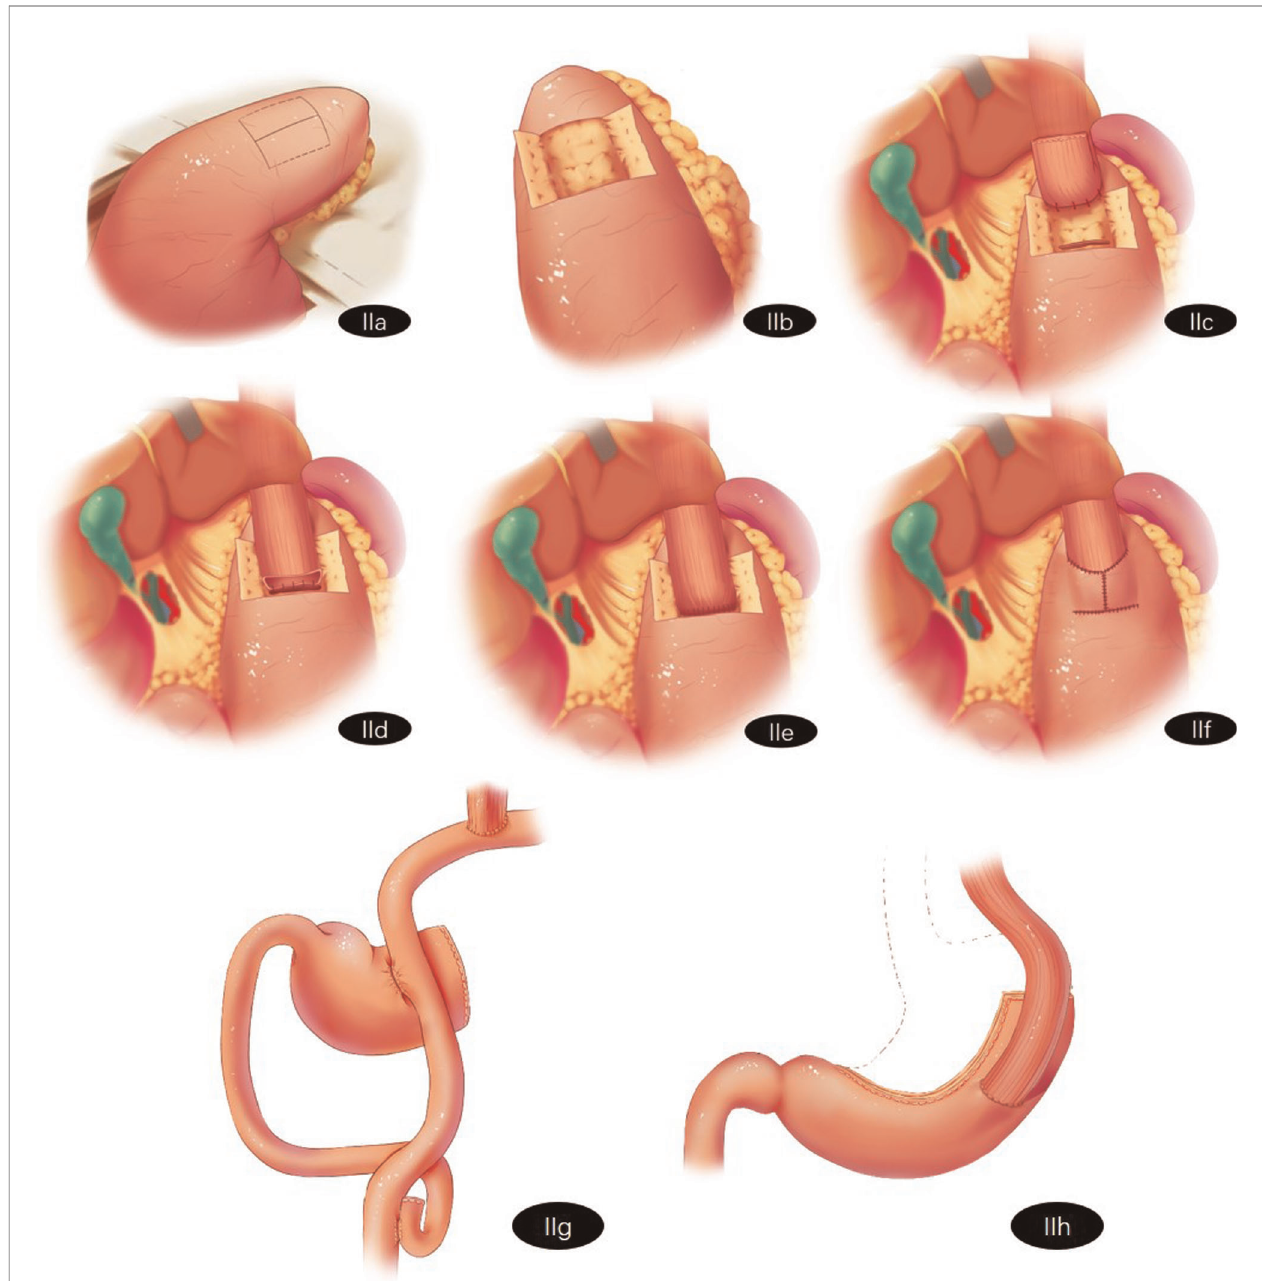
FIGURE 2 | Schematic representation of reconstruction surgery of the digestive tract after proximal gastrectomy ( A ) Kamikawa: A “ H"-shaped seromuscular fl ap (3.0 cm×3.5 cm) will be marked on the anterior wall of the remnant stomach near the greater curvature of the stomach. ( B ) Kamikawa: The sarcoplasmic fl ap will be dissected between the submucosa and musculature. ( C ) Kamikawa: The gastric mucosa “ window ” with similar width to the esophagus will be made at the lower edge of the sarcoplasmic fl ap for anastomosis. Traction will be performed on the esophagus. Three to four stitches will be used to fi x the posterior wall of the esophagus which is 5 cm away from the esophageal stump and the gastric stump at the upper edge of the sarcoplasmic fl ap. ( D ) Kamikawa: The whole esophagus will be sutured continuously with the gastric mucosa and submucosa. ( E ) Kamikawa: The whole anterior wall of the esophagus and the whole stomach will be sutured intermittently. ( F ) Kamikawa: Both sides of the sarcoplasmic fl ap will be sutured intermittently in the shape of a “ Y ” and fi xed with the esophagus to cover the anastomosis. ( G ) Double- fl ap reconstruction ( H ) Tube-like stomach reconstruction.